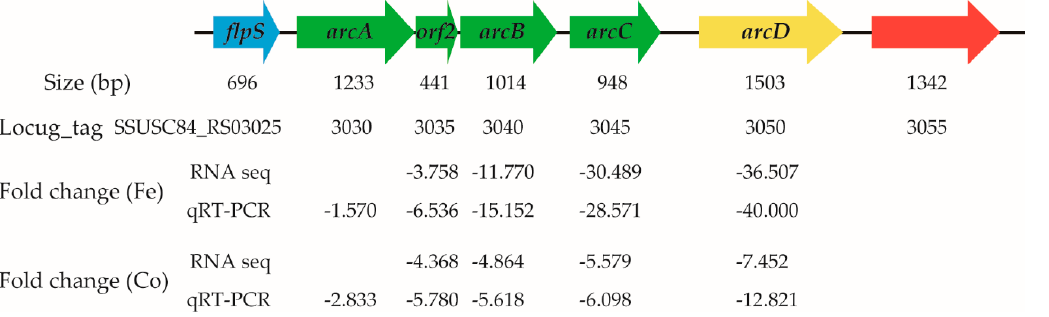
Figure 8. Expression of the genes in the arginine deiminase system after treatment with ferrous iron and cobalt. Expression level of each gene is shown under its locus_tag. The negative values indicate down-regulation. The size for each gene is shown above its locus_tag. The genes arcA , orf2 , arcB , and arcC form an operon, and encode arginine deiminase, acetyltransferase, ornithine carbamoyltransferase, and carbamate kinase, respectively. The flpS and arcD genes encode a transcription regulator and arginine-ornithine antiporter, respectively. The qRT-PCR results were analyzed using the unpaired Student’s t test, and a p -value < 0.05 was considered to be significant.